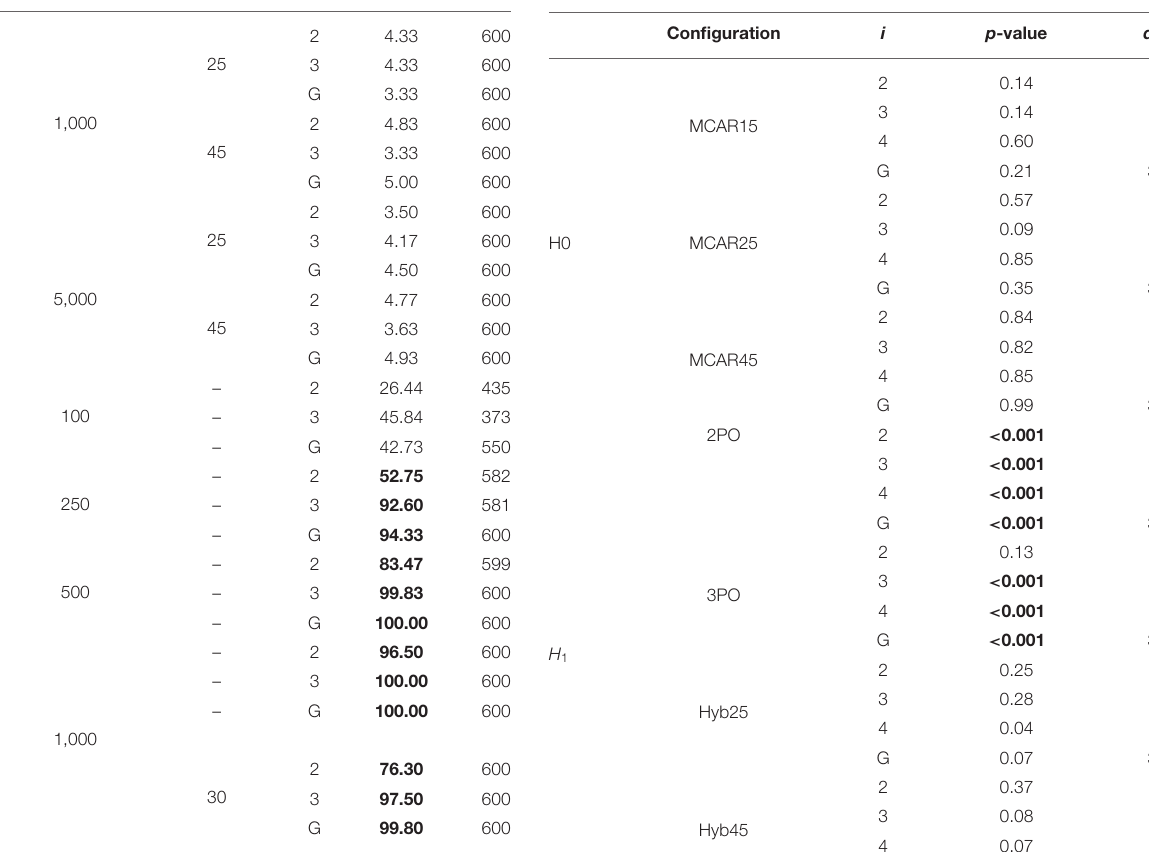
TABLE 5 | Testing the mixture property of partial observations: simulation results. Scenario Sample size